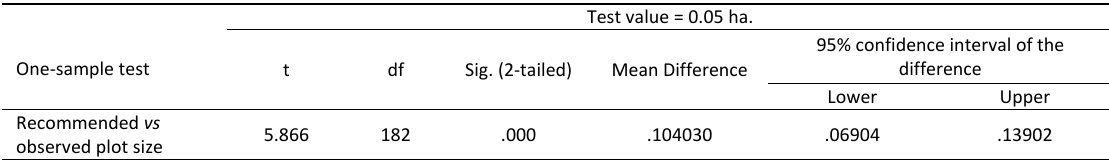
Table 7: Test for significance on compliance with land subdivision planning standard